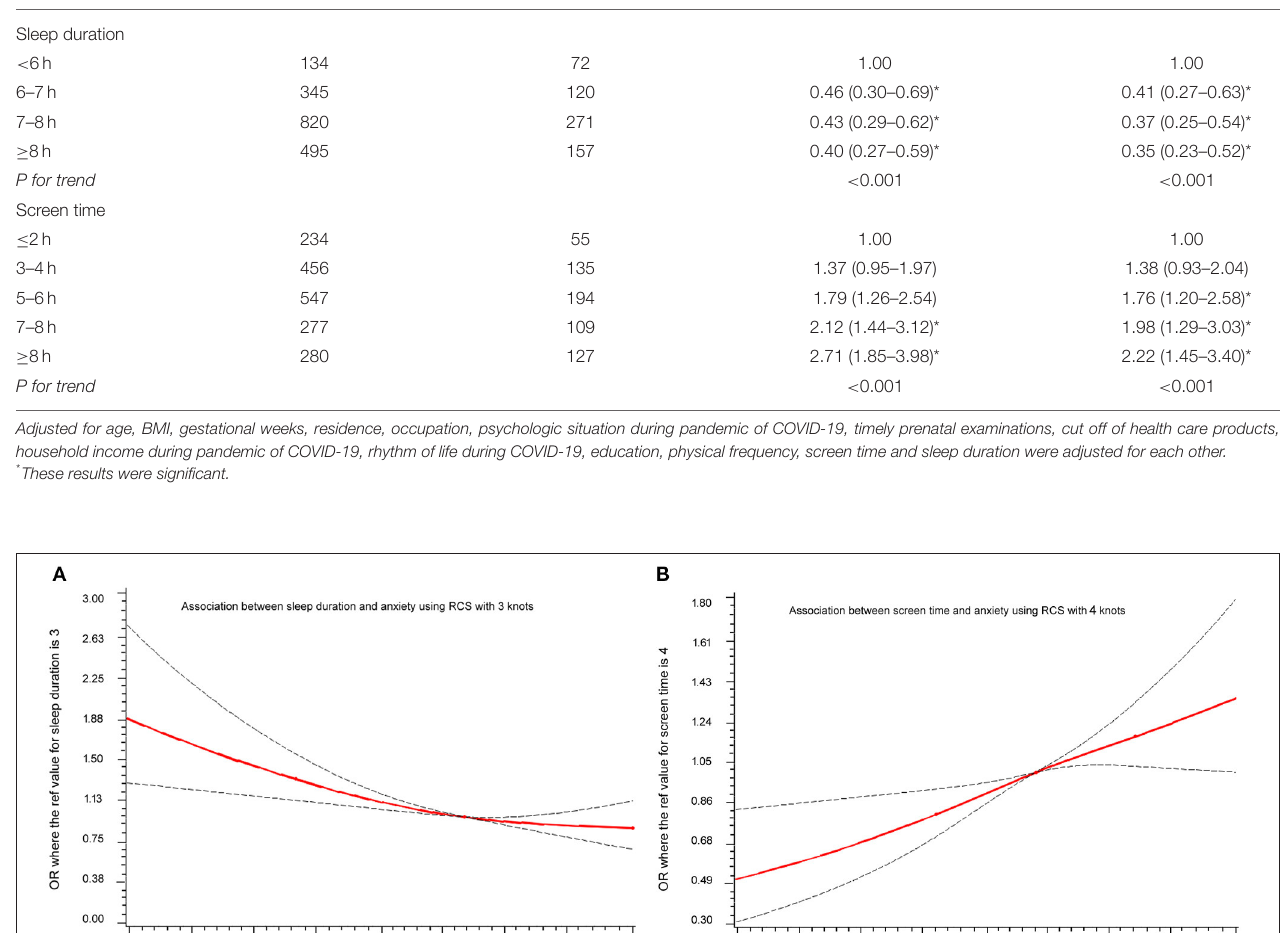
TABLE 2 | Odds ratios (95% CI) for anxiety according to sleep duration and screen time. Variables